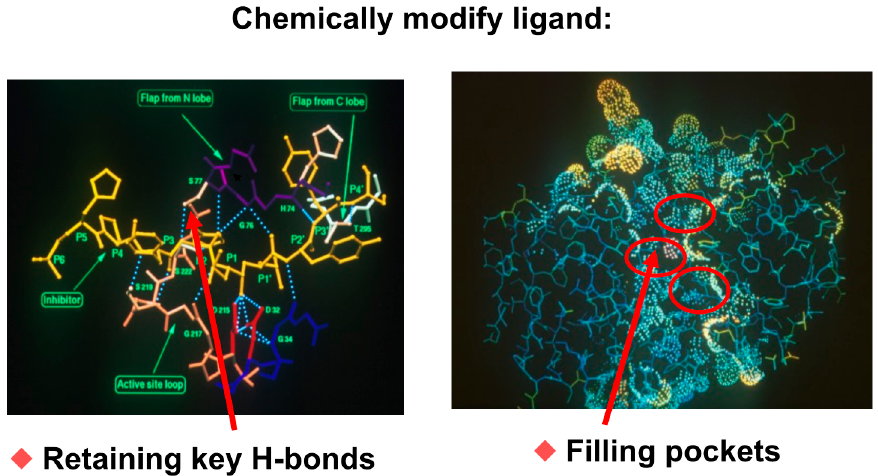
Figure 5. The structural basis of design of antihypertensives targeting renin guided by knowledge of H bonding of substrate analogues (left-hand side) and pocket occupation (right-hand side).